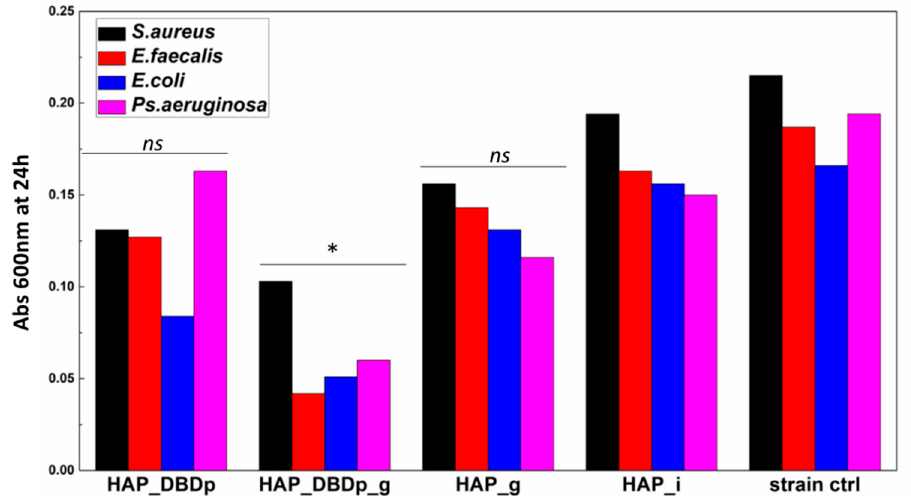
Figure 5. Planktonic bacterial cells grown in the presence of the developed HAP samples expressed as optical density (Abs 600 nm) values of the cultures incubated in nutritive broth for 24 h in the presence of HAP variants (one-way ANOVA, * p < 0.05, ns = not significant; when comparing plasma and fluoride-treated samples (HAP_DBDp, HAP_DBDp_g, and HAP_g) to untreated HAP_i sam- ple).